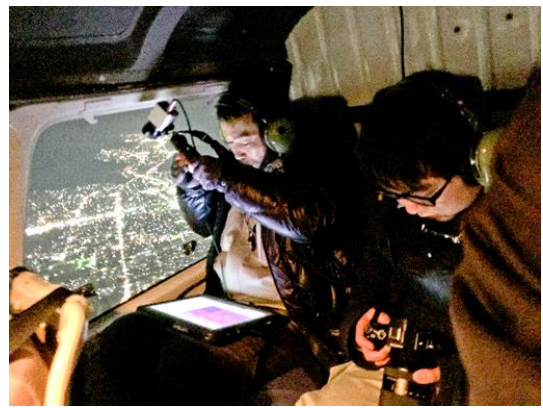
Figure 2. Observation conditions in the helicopter. The person on the left is observing with a thermal infrared camera. The person on the right is checking the images taken by the ultrasensitive camera. The helicopter window is